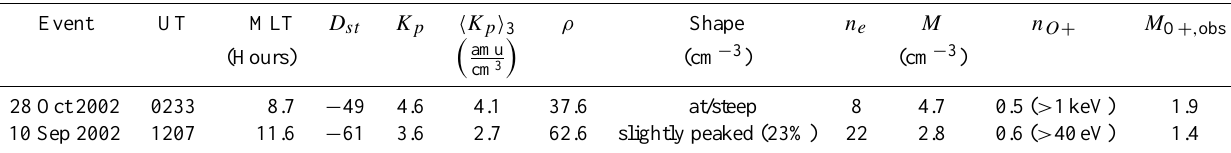
Table 4. Densities for the two events.